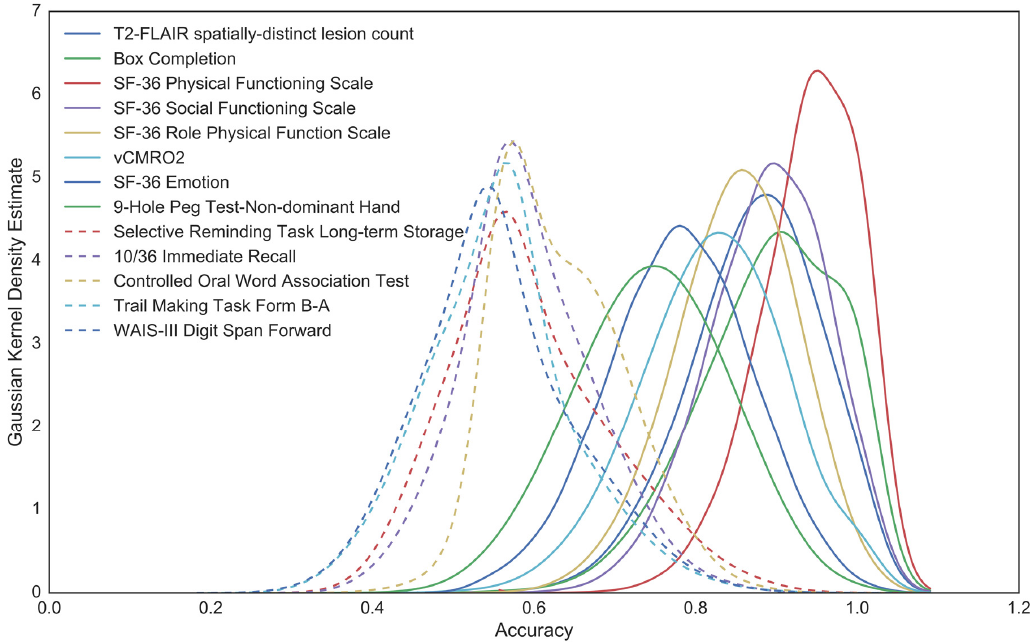
Figure 6. Smoothed density estimates of BCa-bootstap distributions. Distributions of significant (solid lines) and bottom 5 (dashed lines) within-sample predictors of MS status are illustrated. Note : because of smoothing, tails of distributions may exceed 1.